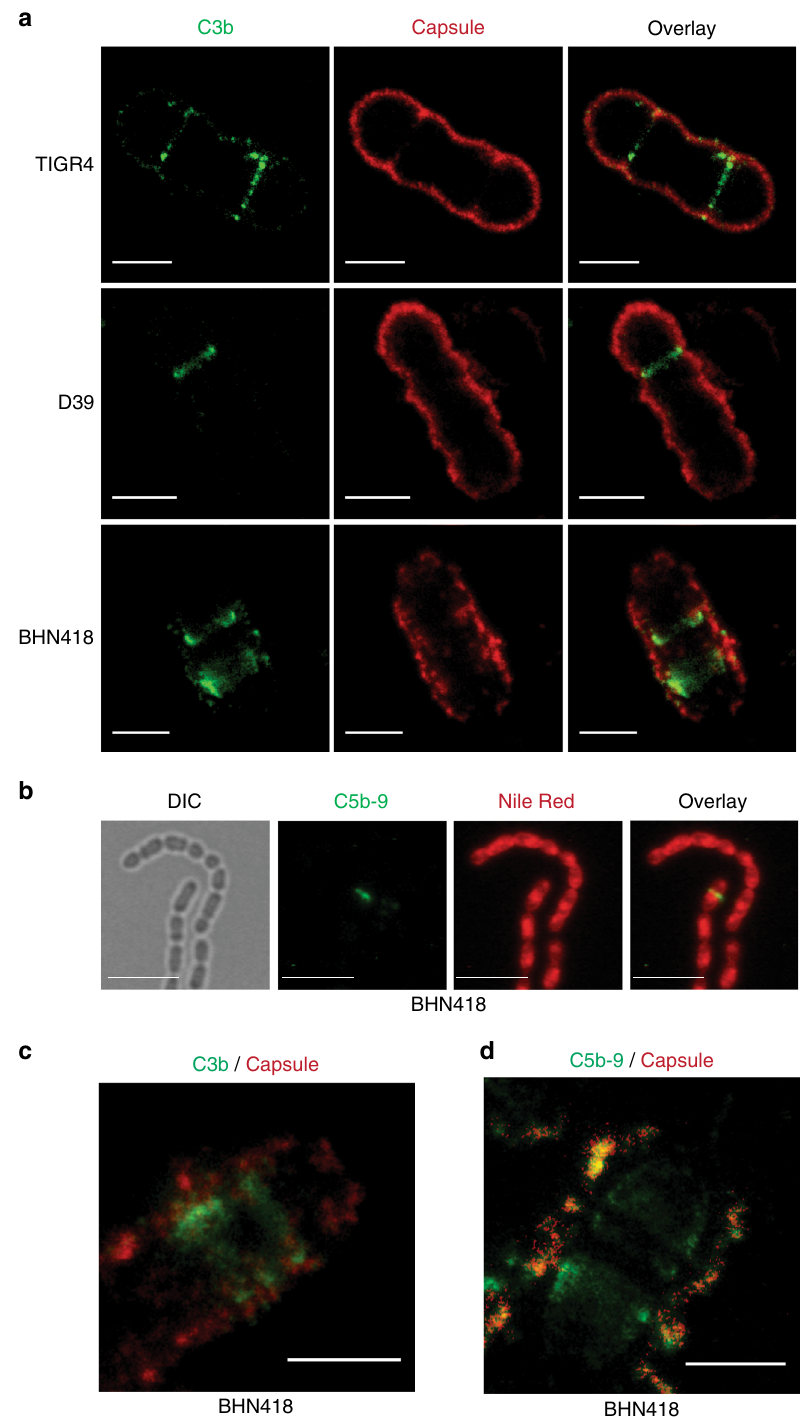
Fig. 2 C3b and C5b-9 MAC complexes localize underneath the capsular layer. a Super-resolution STED microscopy images of strains TIGR4, D39, and BHN418 after incubation with 20% normal human serum. Bacteria were sequentially stained with goat anti-C3 antibody followed by Atto647N labeled secondary antibody (green). The capsule was detected using respective rabbit anti-capsule serum and anti-rabbit Alexa fl uor 594 antibody (red). Scale bar = 1 µ m. b Representative immuno fl uorescence images of C5b-9 deposition on strain BHN418 after incubation with 20% normal human serum. Bacteria were sequentially stained with mouse anti-C5b-9 antibody and anti-mouse Alexa fl uor 488 labeled secondary antibody (green). Bacterial membranes were stained with nile red (red). Scale bar = 5 µ m. c Representative super-resolution STED microscopy image of C3b deposition on strain BHN418 after incubation with 20% normal human serum. Bacteria were stained for C3b and the capsule as in a . d Representative super-resolution STED microscopy image of C5b-9 deposition on strain BHN418 after incubation with 20% normal human serum. Bacteria were sequentially stained with mouse anti-C5b-9 antibody followed by Atto647N labeled secondary antibody (green). The capsule was detected using rabbit anti-6B capsule serum and anti-rabbit Alexa fl uor 594 antibody (red). c , d Scale bar = 1 µ